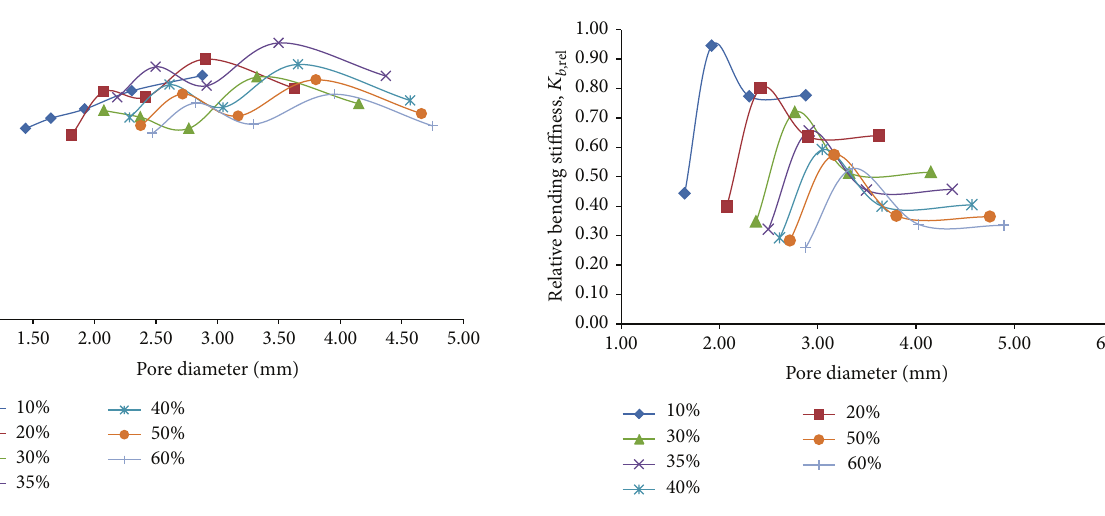
Figure 11: Plots depicting variation of relative bending stiffness, 𝐾 𝑏, rel , against pore diameter for different percentages of porosity for 3D porous FE beam models subjected to flexural loading